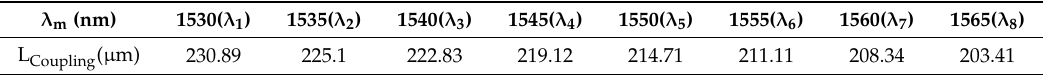
Table 2. The coupling length